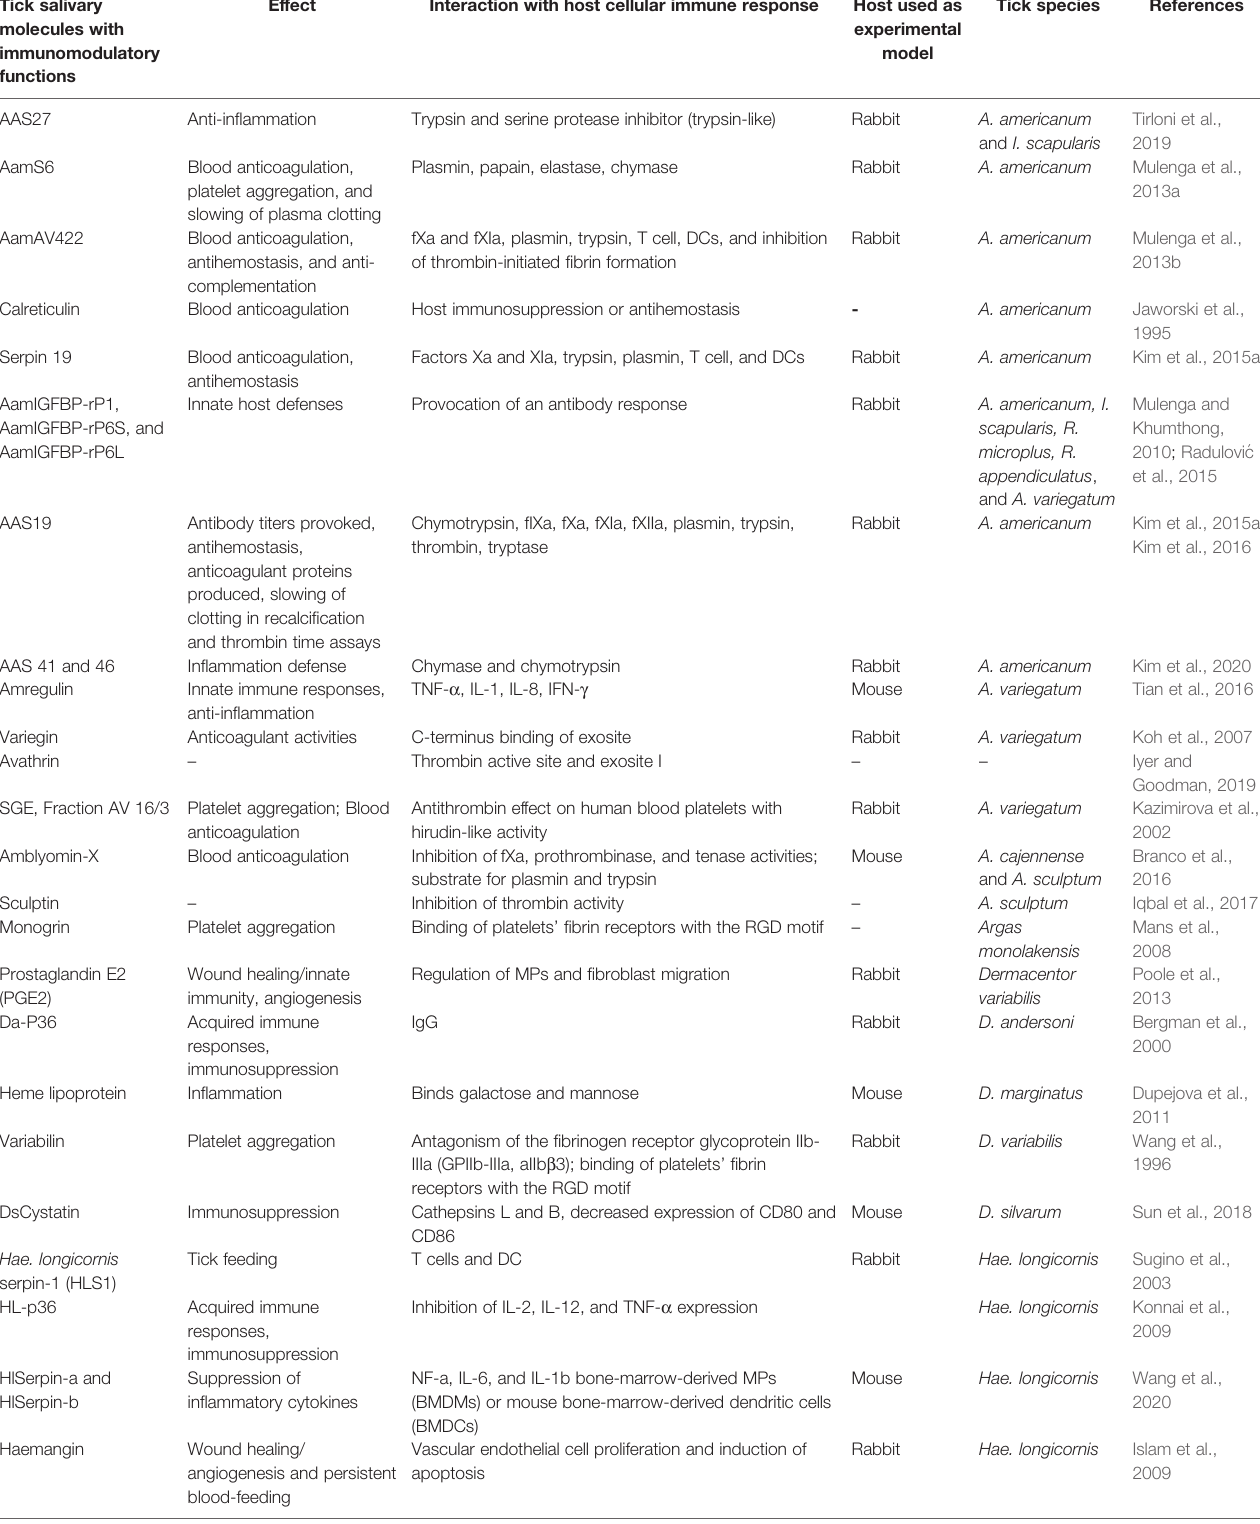
TABLE 1 | Tick-derived immunomodulatory molecules and their effects and interaction with host immune